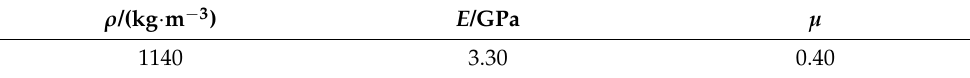
Table 4. Material parameters of nylon